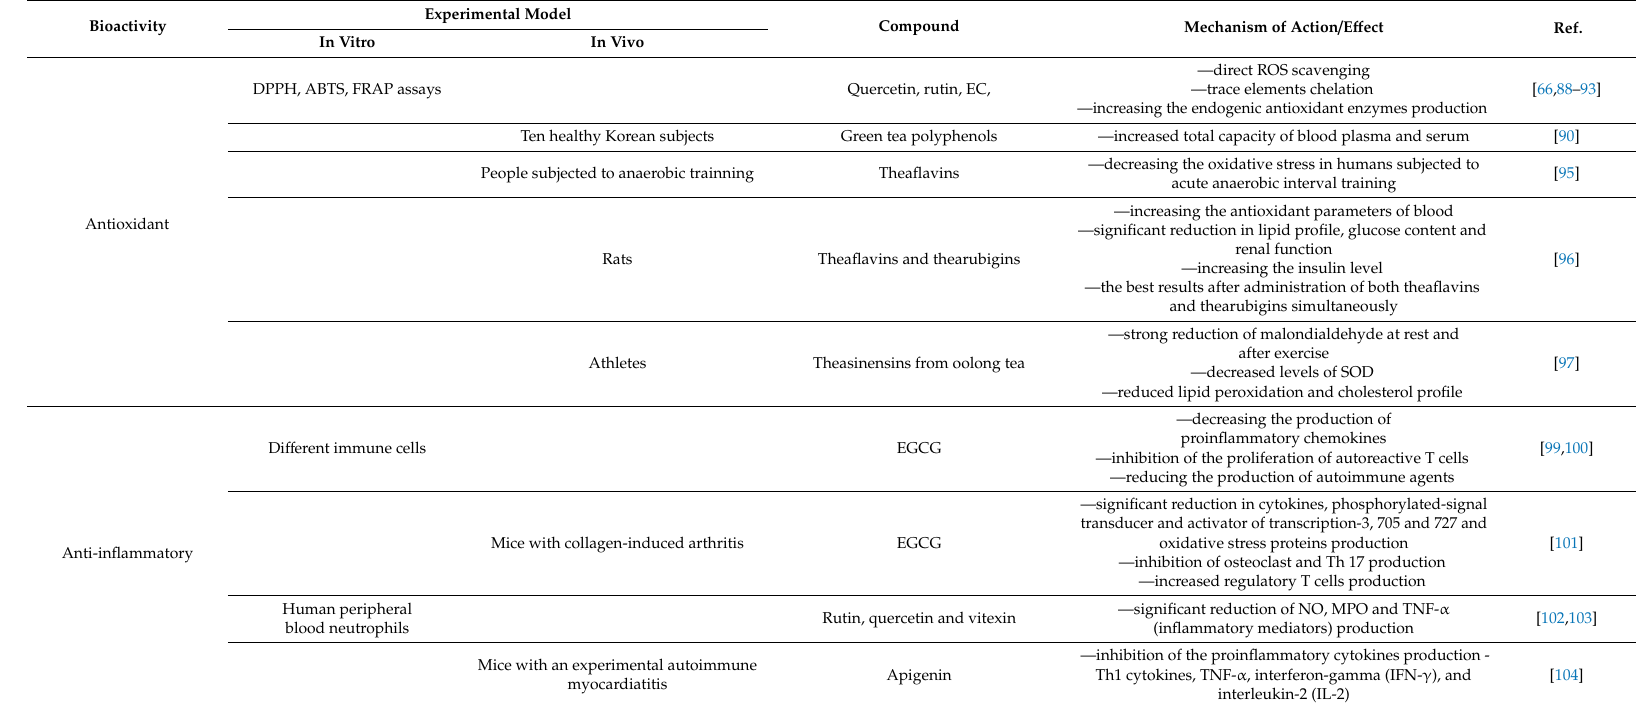
Table 2. Health benefits of dietary